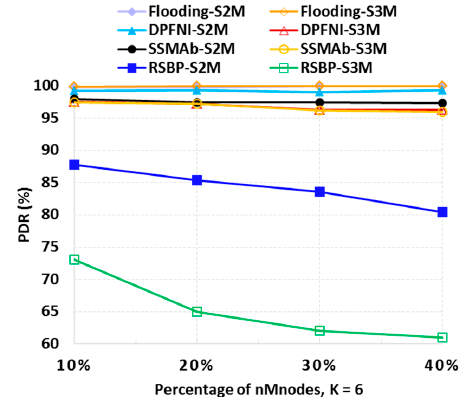
Figure 12. Packet delivery ratio according to the percentage of mobile nodes ( K = 6).